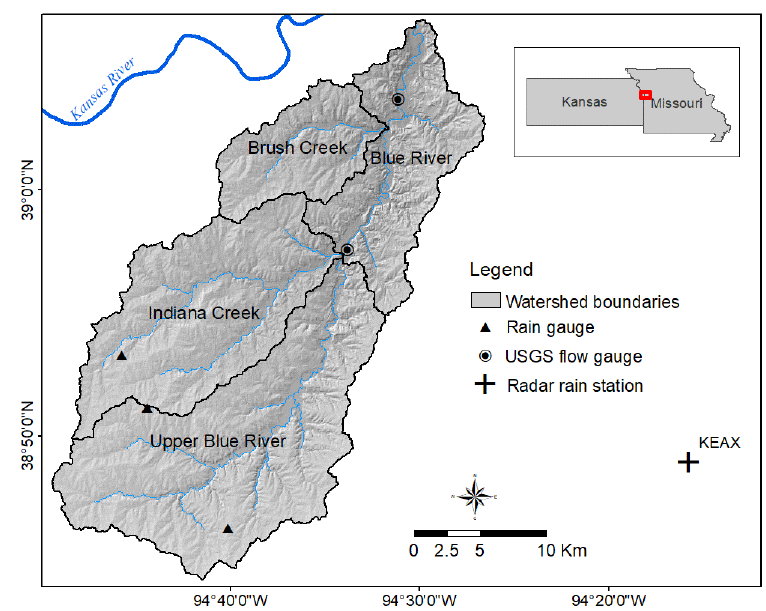
Figure 1. Location of the study area, the Blue River watershed, with major sub-watersheds and the locations of rain gauges, USGS streamflow gauges, and the Kansas City Radar rain station.